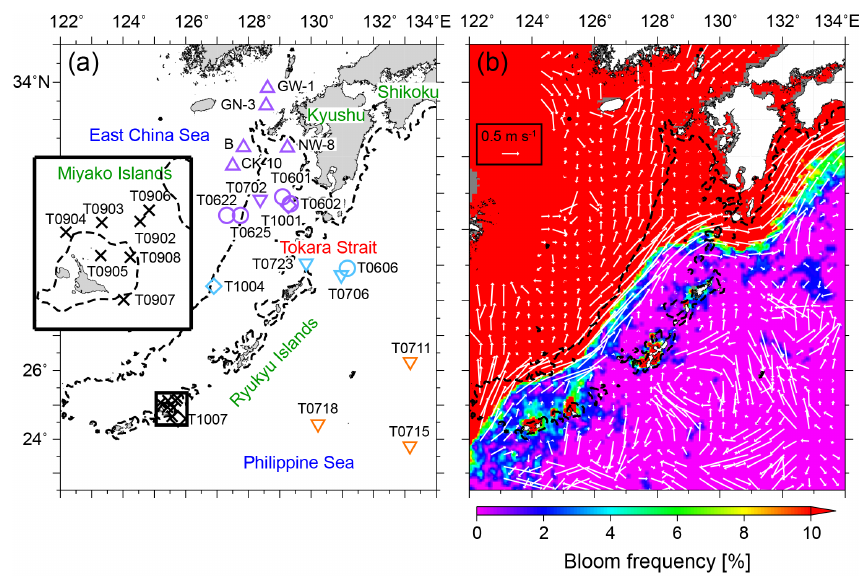
Figure 1. (a) Sampling stations during the KT-06-21 (circles), KT-07-22 (inverted triangles), KT-09-17 (crosses), KT-10-19 (diamonds), and 242 (triangles) cruises. Symbols of stations located in the East China Sea, the Kuroshio, the Philippine Sea, and near the Miyako Islands are indicated in purple, light blue, orange, and black, respectively. (b) Climatological surface current fields during summer (1953–2008) from geoelectrokinetograph measurements and ship-mounted ADCP data. The background contour represents the percentage of chlorophyll a of >0.15mgm − 3 during summer between 2003 and 2009. Dashed lines indicate 200m